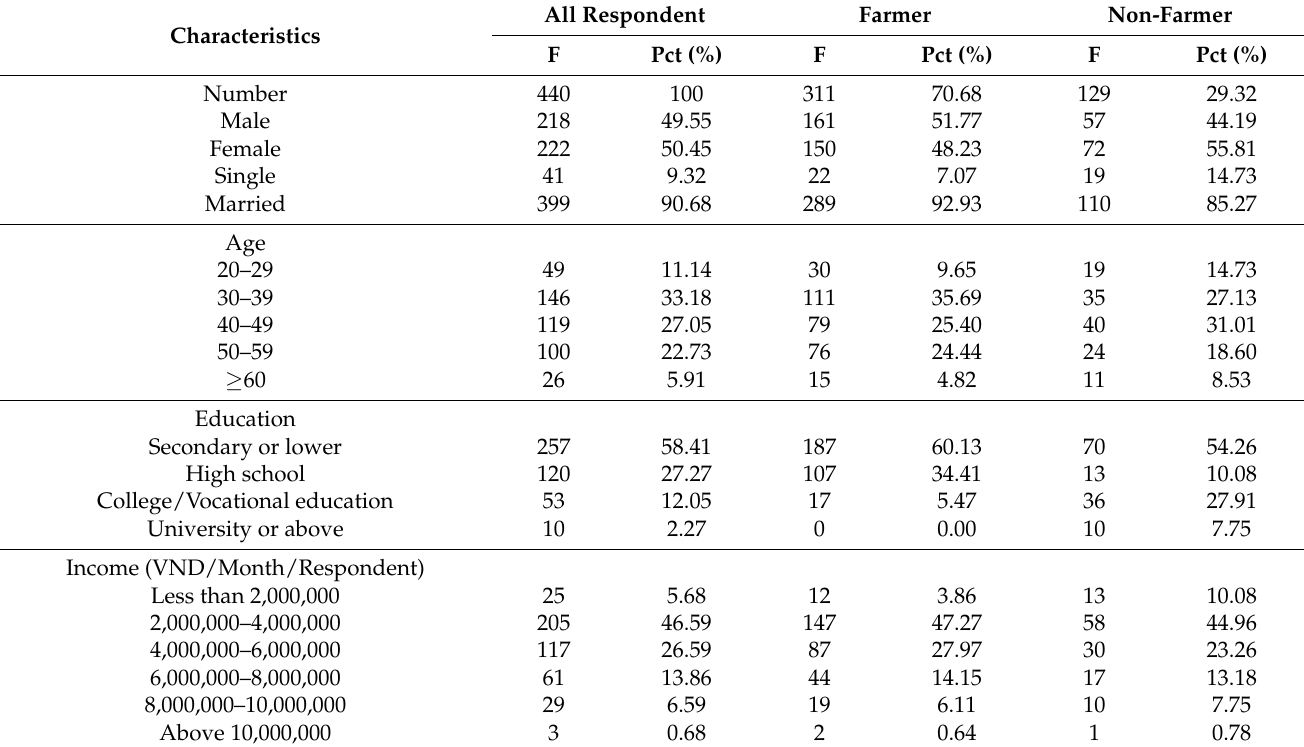
Table 2. Respondents’ social backgrounds and HEC attitude and